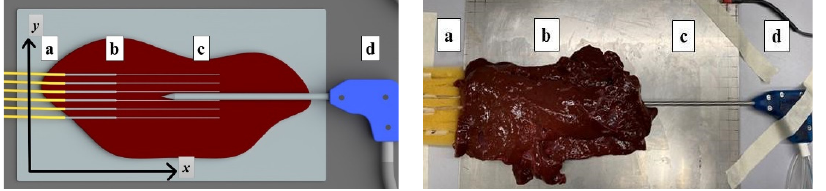
Figure 6. The scheme and photographic view fibers ( a ), bovine liver ( b ), negatively charged plate ( c ), and the applicator ( d ) in the vicinity.